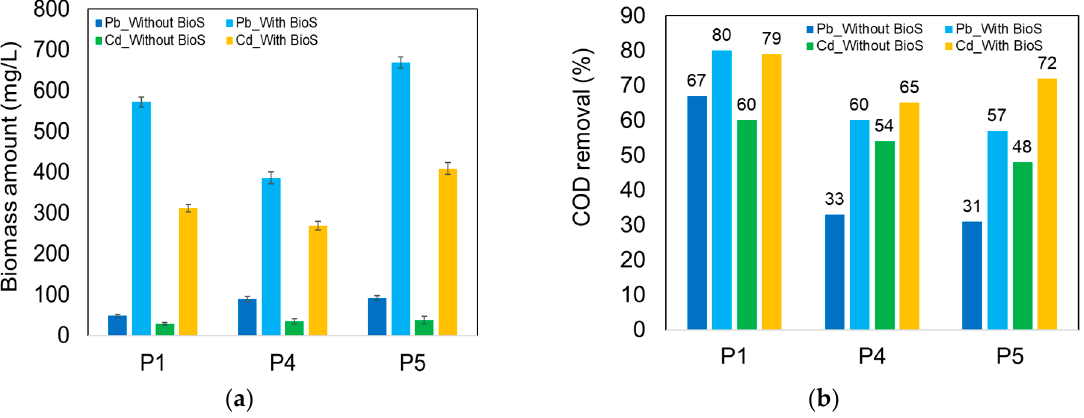
Figure 7. The influence of biosurfactant on ( a ) the amount of yeast biomass; ( b ) removal of